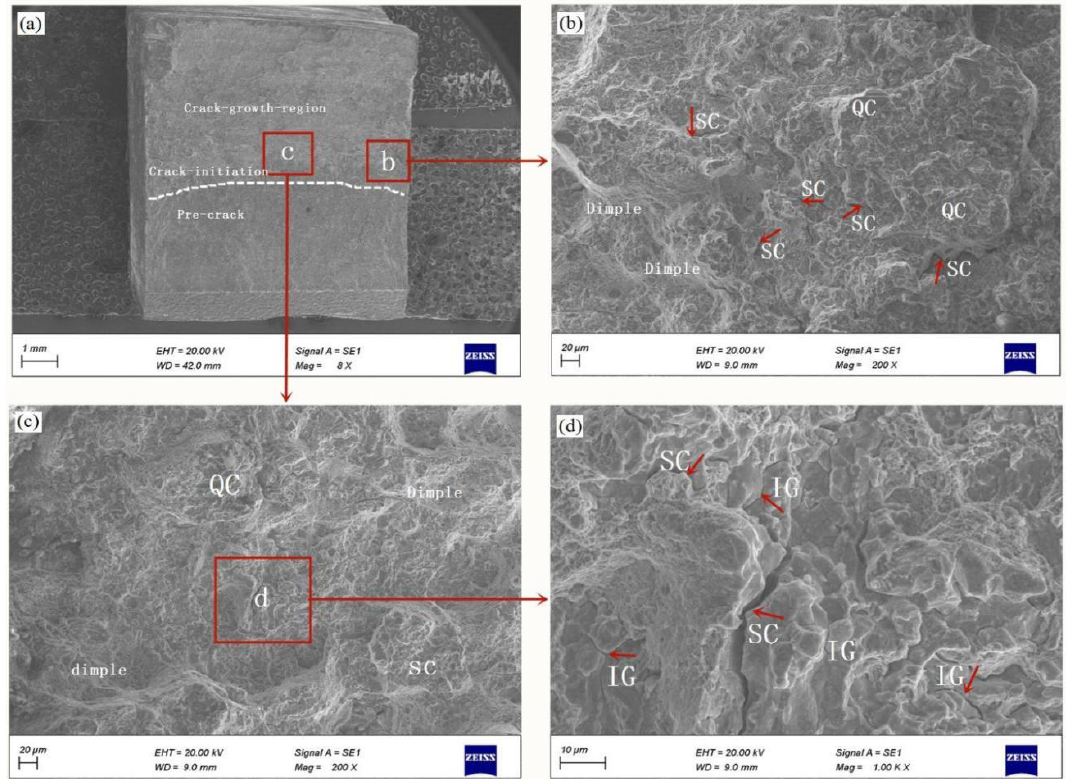
Figure 4. SEM images of the fracture surface of 45CrNiMoVA low alloy steel CT specimen H- charged for 36 h: ( a ) overview of the fracture surface; ( b , c ) high magnification SEM images of the indicated region in image ( a ); ( d ) high magnification SEM image of the indicated region in image ( c ); (red arrowheads indicate secondary cracks (SCs) and white arrowheads indicate tear ridges). QC: quasi-cleavage; IG: intergranular fracture; MVC: microvoid coalescence.